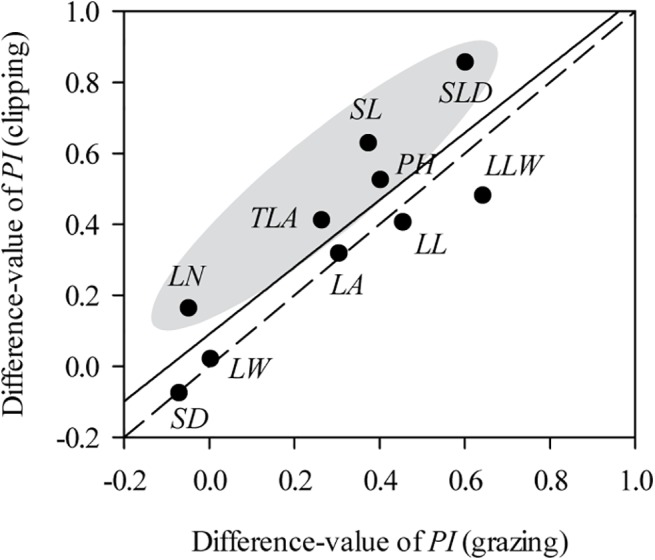
Relationships between the difference-value of plasticity index (PI) of grazing and clipping treatments.Difference-value of PI: PI (in situ)–PI (hydroponics). The correlation between the differences in PI was tested by Pearson’s method (r = 0.87, P < 0.01). The gray area represents traits that exhibit a larger change in PI after clipping treatments than grazing treatments. Solid line: linear fit; dashed line: 1:1 line.